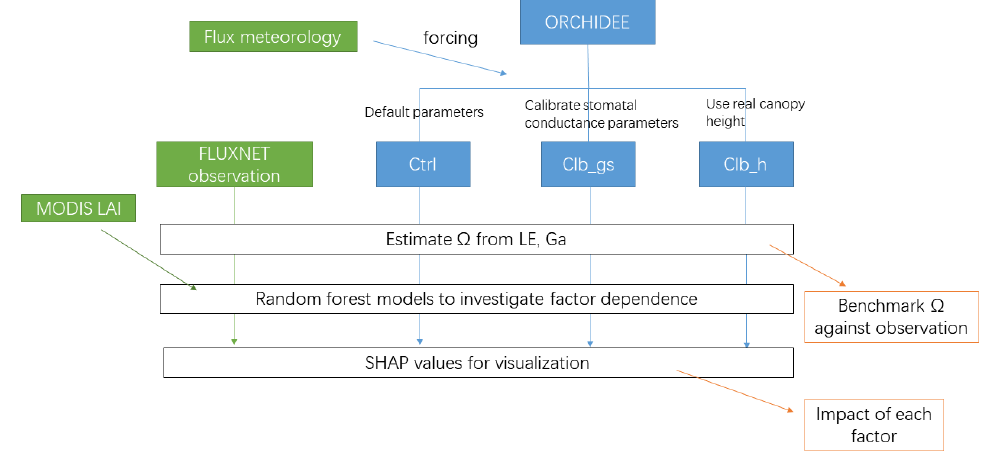
Figure 1. Workflow of this study.